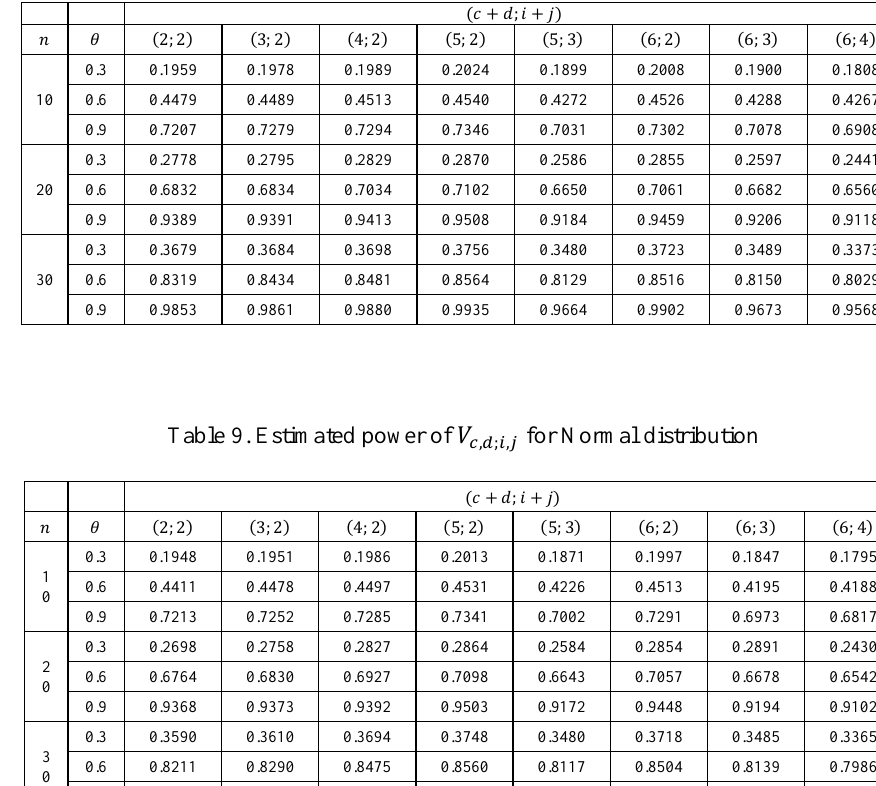
Table 8. Estimated power of 𝑇